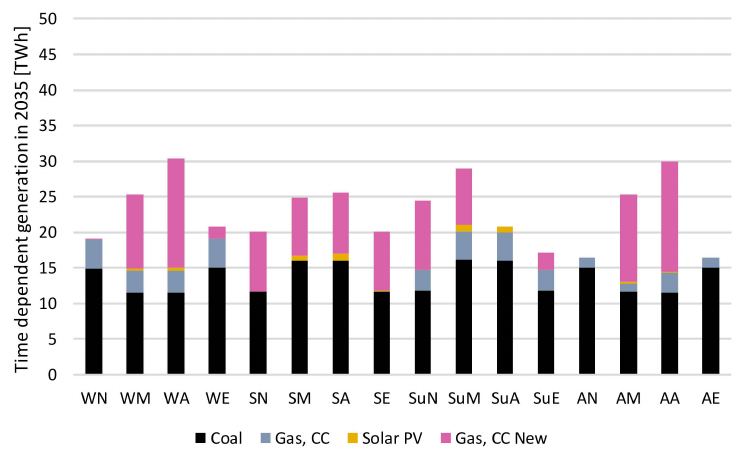
Figure 11. Generation (TWh) per time slice in 2035 in the REF scenario—with code modifications.